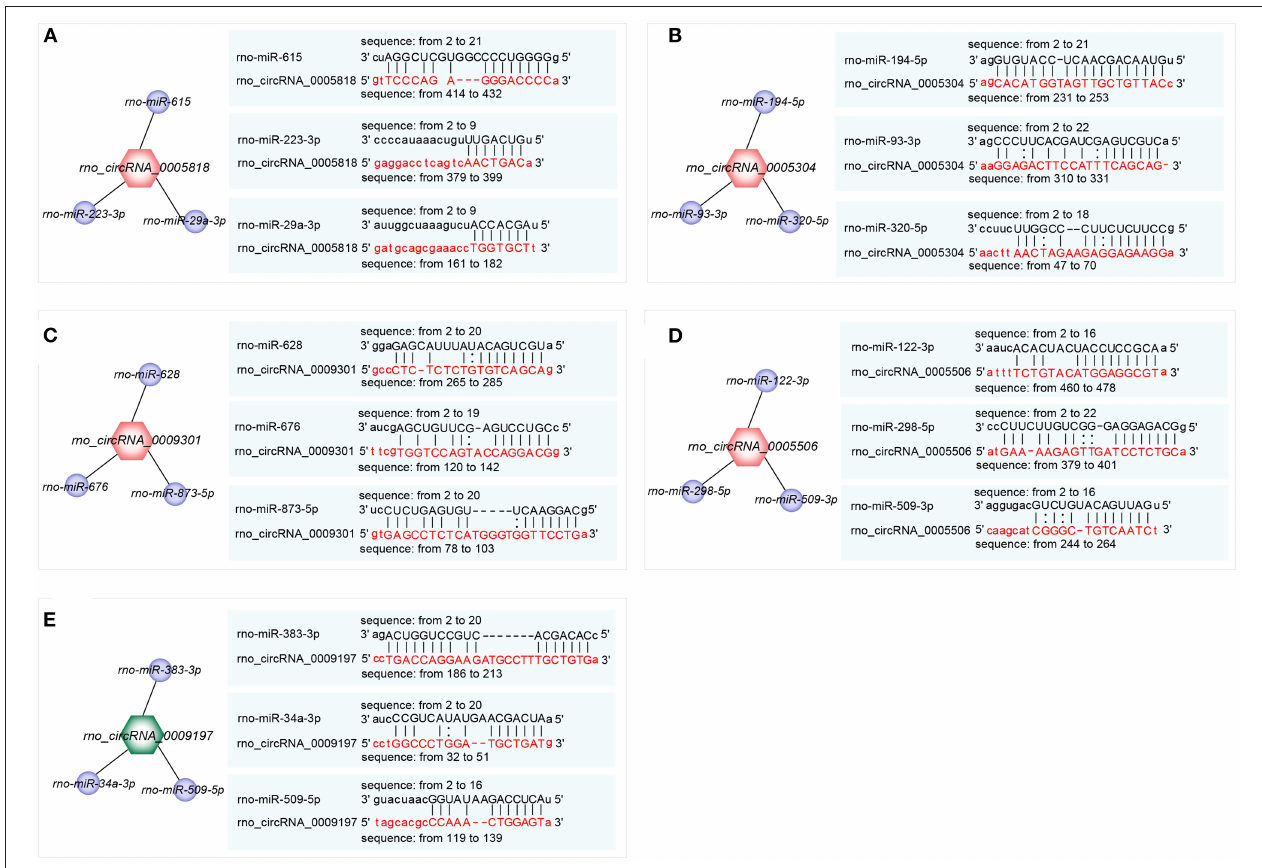
FIGURE 4 | Prediction of the binding sites of circRNA-miRNA. (A–E) The top 3 miRNAs associated with each selected circRNA and the predicted binding sites. (A) rno_ circRNA_0005818 target pairs: rno_circRNA_0005818 → rno-miR-615; rno_circRNA_0005818 → rno-miR-223-3p; rno_circRNA_0005818 → rno-miR-29a-3p; (B) rno_circRNA_0005304 target pairs: rno_circRNA_0005304 → rno-miR-194-5p; rno_circRNA_0005304 → rno-miR-93-3p; rno_circRNA_0005304 → rno-miR-320-5p; (C) rno_circRNA_0009301 target pairs: rno_circRNA_0009301 → rno-miR-628; rno_circRNA_0009301 → rno-miR-676; rno_circRNA_0009301 → rno-miR-873-5p; (D) rno_circRNA_0005506 target pairs: rno_circRNA_0005506 → rno-miR-122-3p; rno_circRNA_0005506 → rno-miR-298-5p; rno_circRNA_0005506 → rno-miR-509-3p; (E) rno_circRNA_0009197 target pairs: rno_circRNA_0009197 → rno-miR-383-3p; rno_circRNA_0009197 → rno-miR-34a-3p; rno_circRNA_0009197 → rno-miR-509-5p. Target miRNAs of confirmed circRNAs were predicted using the miRanda software (http://www.miranda.org). circRNA, circular RNA; miRNA, microRNA.